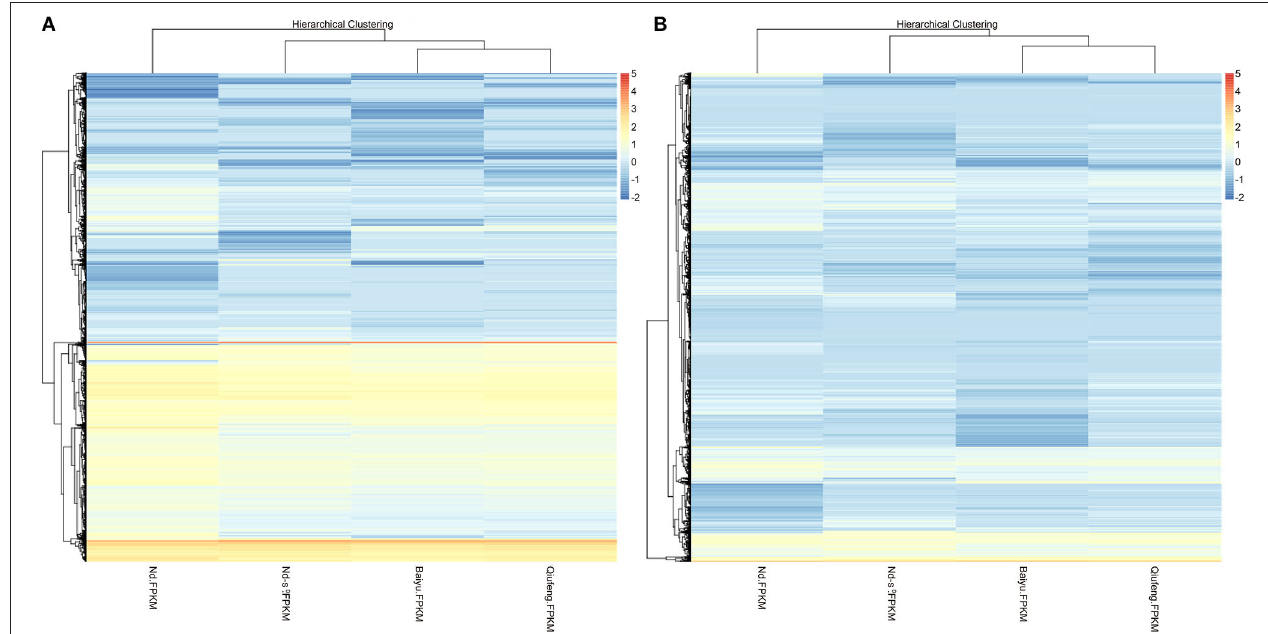
FIGURE 4 | Hierarchical clustering of mRNAs (A) and lncRNAs (B) in Qiufeng, Baiyu, Nd-s D and Nd.